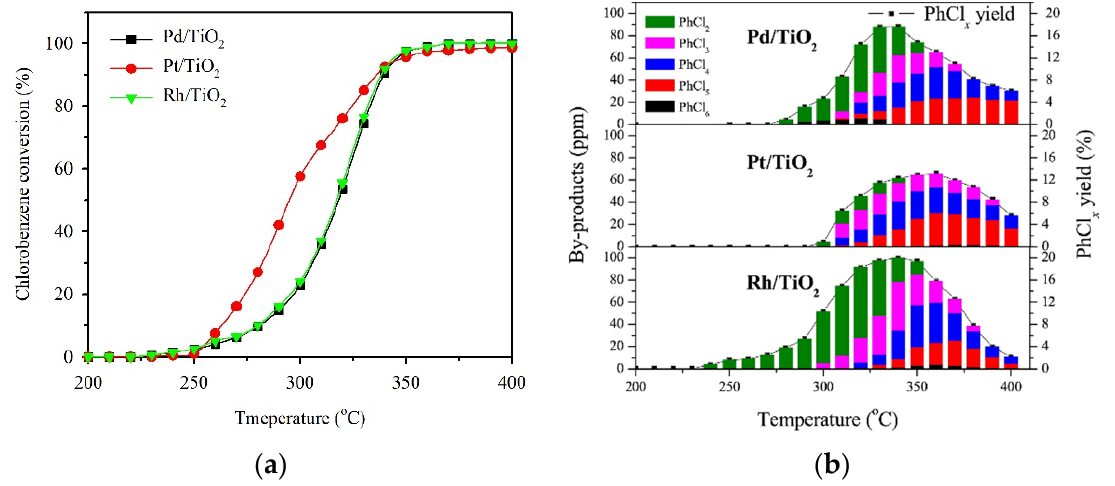
Figure 3. Conversion over Pd/TiO 2 , Pt/TiO 2 , Rh/TiO 2 : ( a ) chlorobenzene conversion and ( b ) by- product yields. Reprinted with permission from ref. [97]. Copyright 2019 Elsevier.